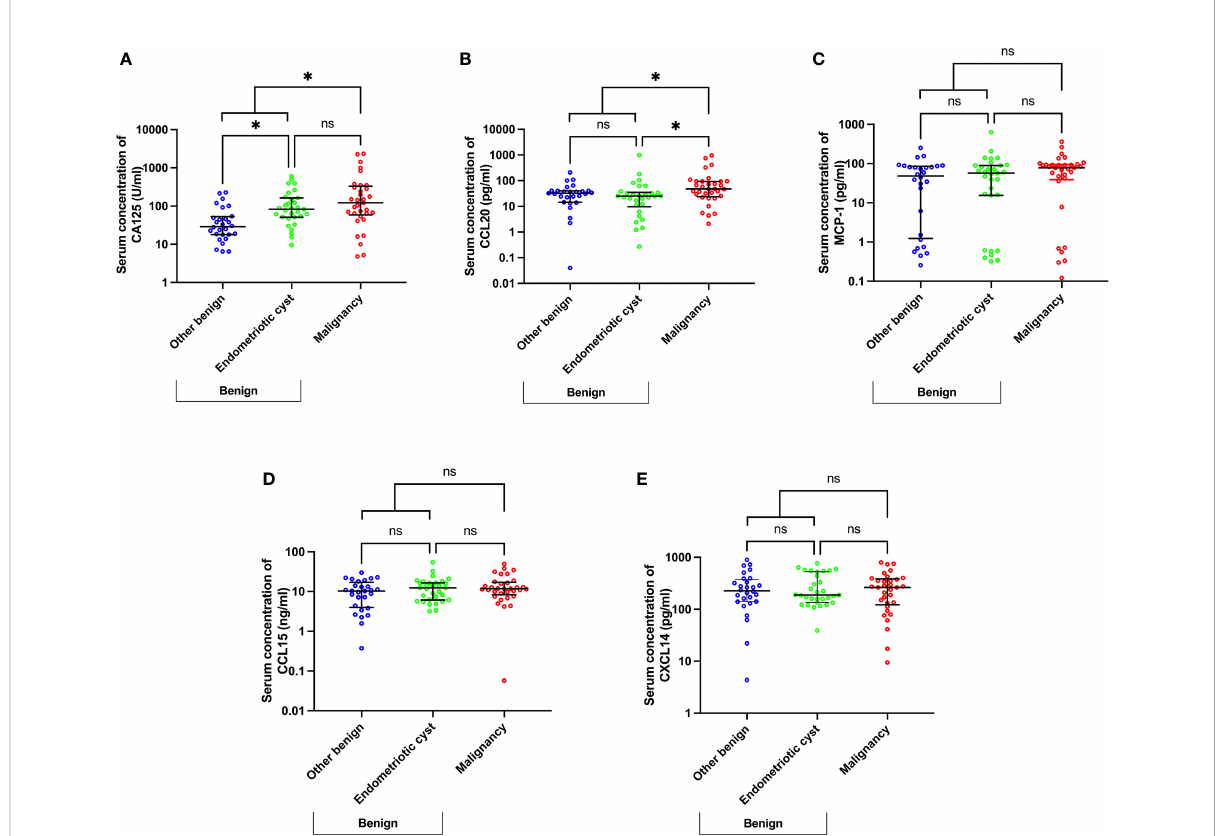
FIGURE 2 Scatter plots of CA125 (A) and chemokine (B – E) concentrations using a subgroup analysis of benign cases, namely endometriotic cysts, other benign diseases, and malignancy. *p<0.05; not signi fi cant (ns). The lower and upper whiskers are interquartile ranges, and the middle line is the